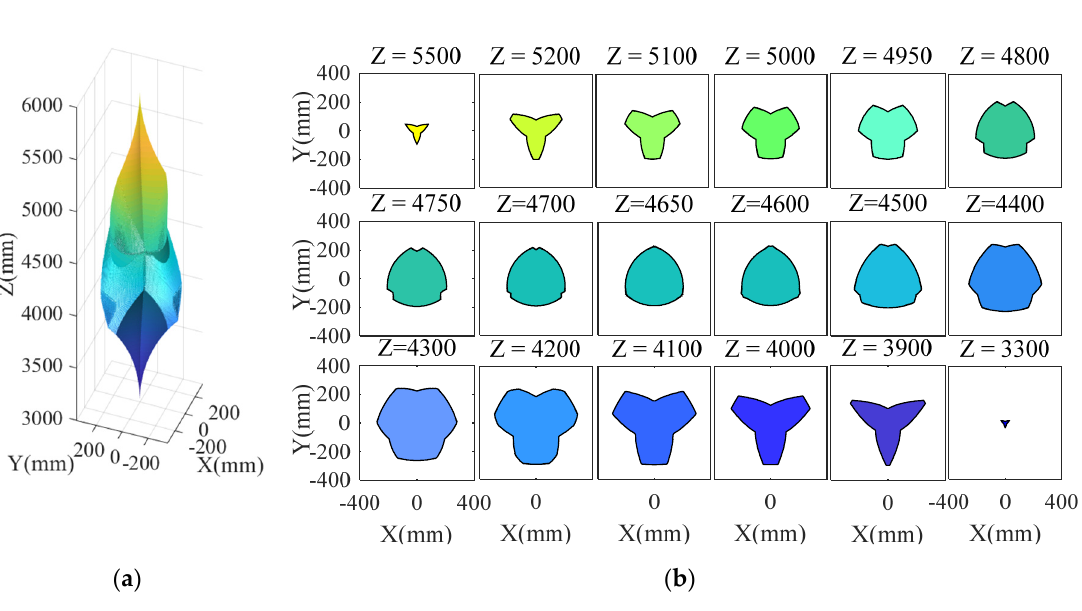
Figure 4. Position workspace of 3-RPS compensation platform; ( a ) 3D shape of the position workspace; ( b ) slice figure of different altitudes.